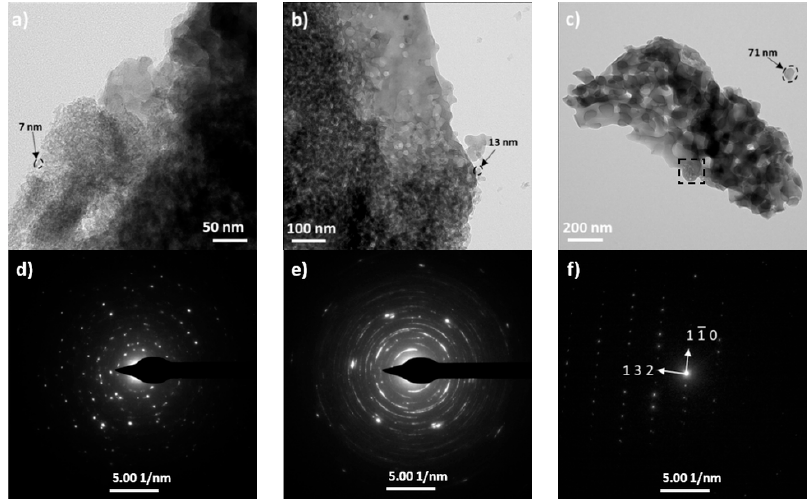
Figure 4. TEM micrographs and the corresponding SAED patterns of the powders calcined at 470 °C ( a , d ), 760 °C ( b , e ) and 960 °C ( c , f ).